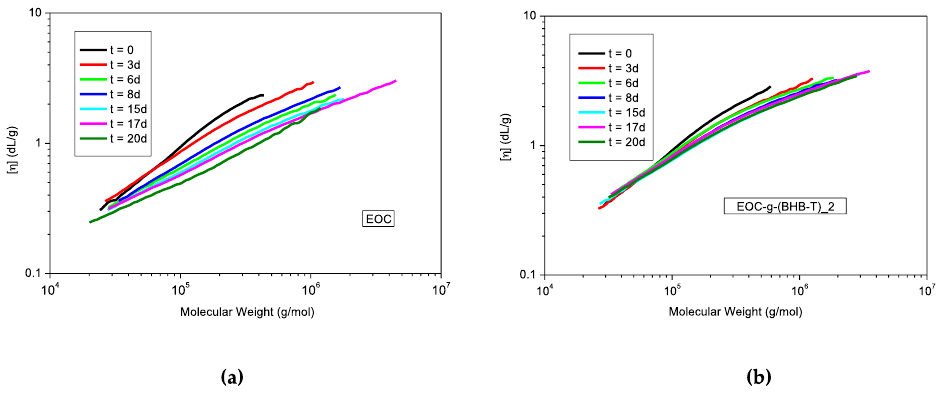
Figure 4. Mark-Houwink-Sakurada (MHS) plot before and during photo-oxidation of EOC ( a ) and EOC- g -(BHB-T)_2 ( b ).